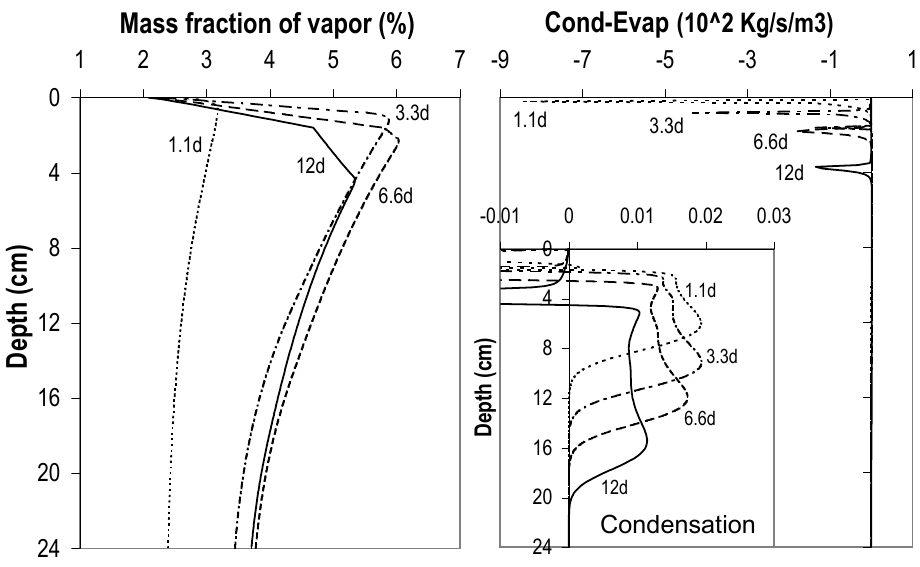
Fig. 5. Computed profiles of vapor mass fraction and evaporation (negative)/condensation (positive) rates for four different times. Note the change in the vapor mass fraction slope at 1.5cm depth owing to the imposition of the reduction in vapor diffusivity on the salt